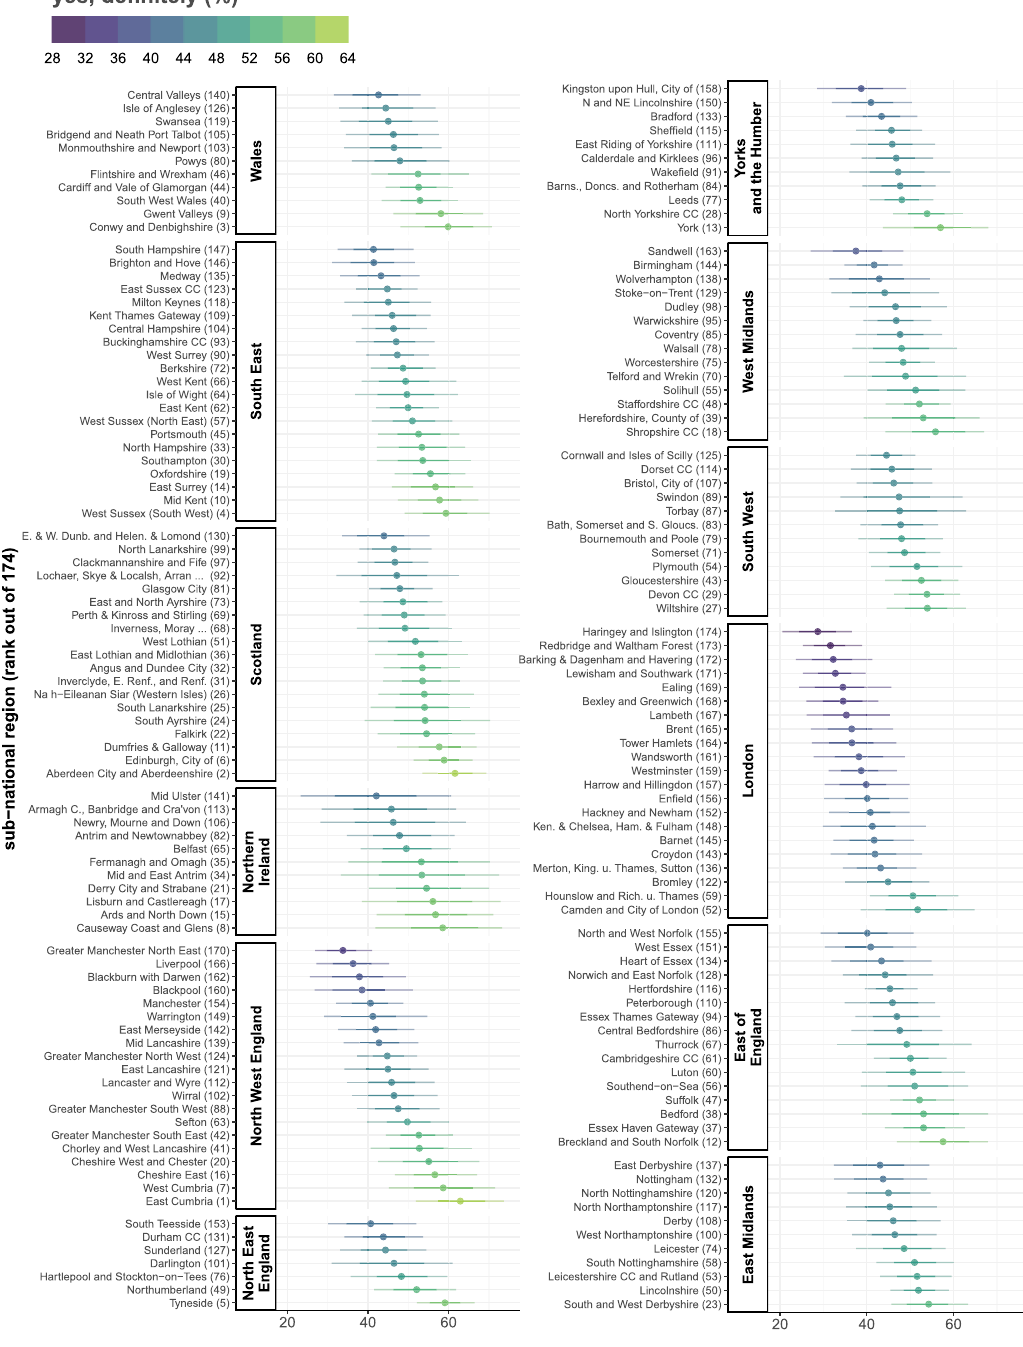
Figure 3. Intent to accept a COVID-19 vaccine ranked within each NUTS-1 region. The MRP estimated proportion of respondents in each of the UK’s 174 NUTS-3 region who would definitely accept a COVID-19 vaccine are shown and ranked within the 12 first-level NUTS regions (NUTS-1). 70% and 95% highest posterior density intervals (horizontal bars) are shown around the mean estimate (dot). Each region is suffixed by its rank (out of 174) according to the estimated proportion who would “definitely” accept a COVID-19 vaccine. East Cumbria (North West England) ranked first, while Haringey and Islington (London) ranked